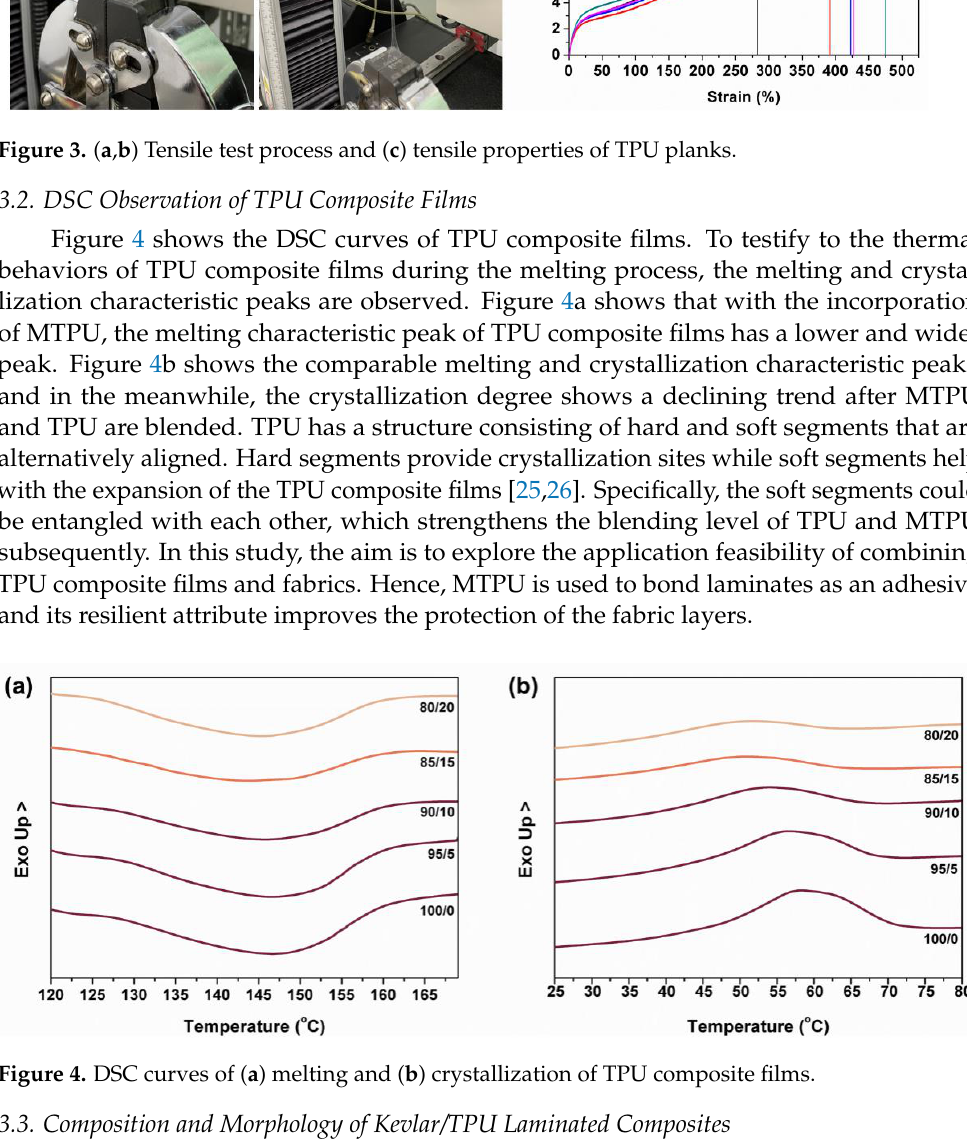
Figure 4. DSC curves of ( a ) melting and ( b ) crystallization of TPU composite films.